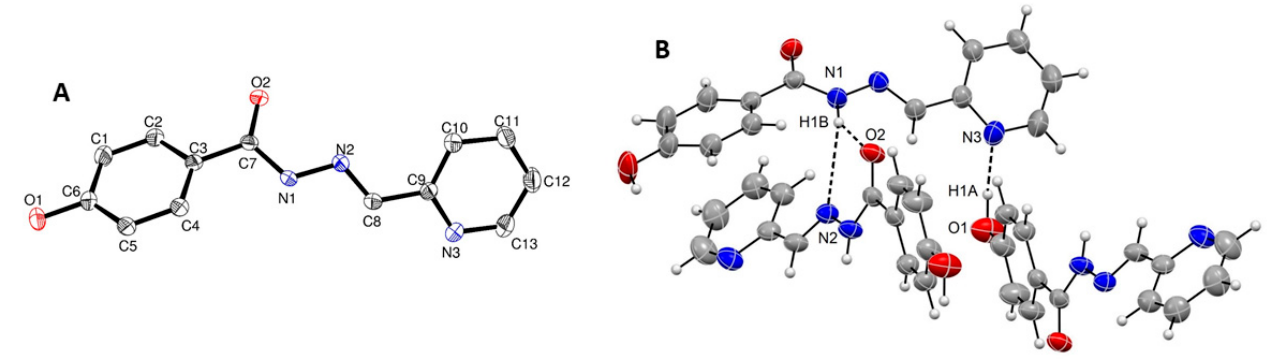
Figure 7. ( A ) Crystal structure of compound 5 . ( B ) Packing in the crystal showing the arrangement of three molecules of compound 5 , and the hydrogen bonds.